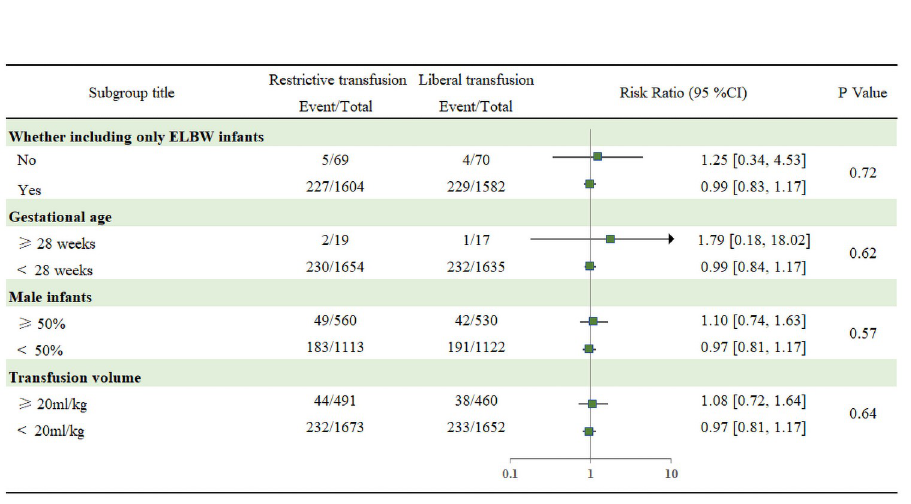
PLOS ONE | https://doi.org/10.1371/journal.pone.0256810 August 30,